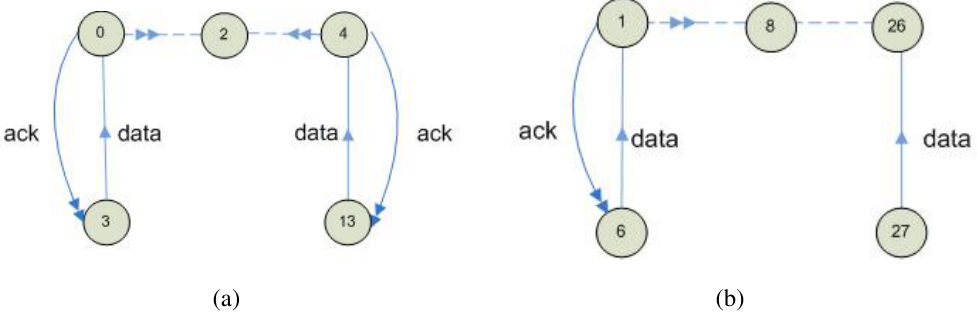
Figure 6. Example of: (a) No color conflict; (b) Color